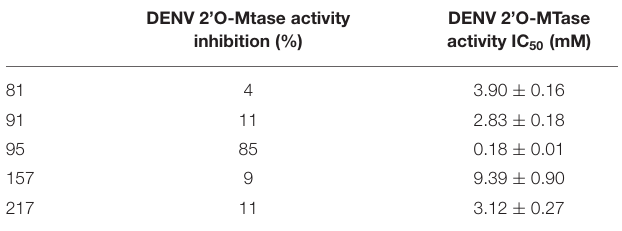
TABLE 2 | Inhibition and potency data from the final hits (Coutard et al.,